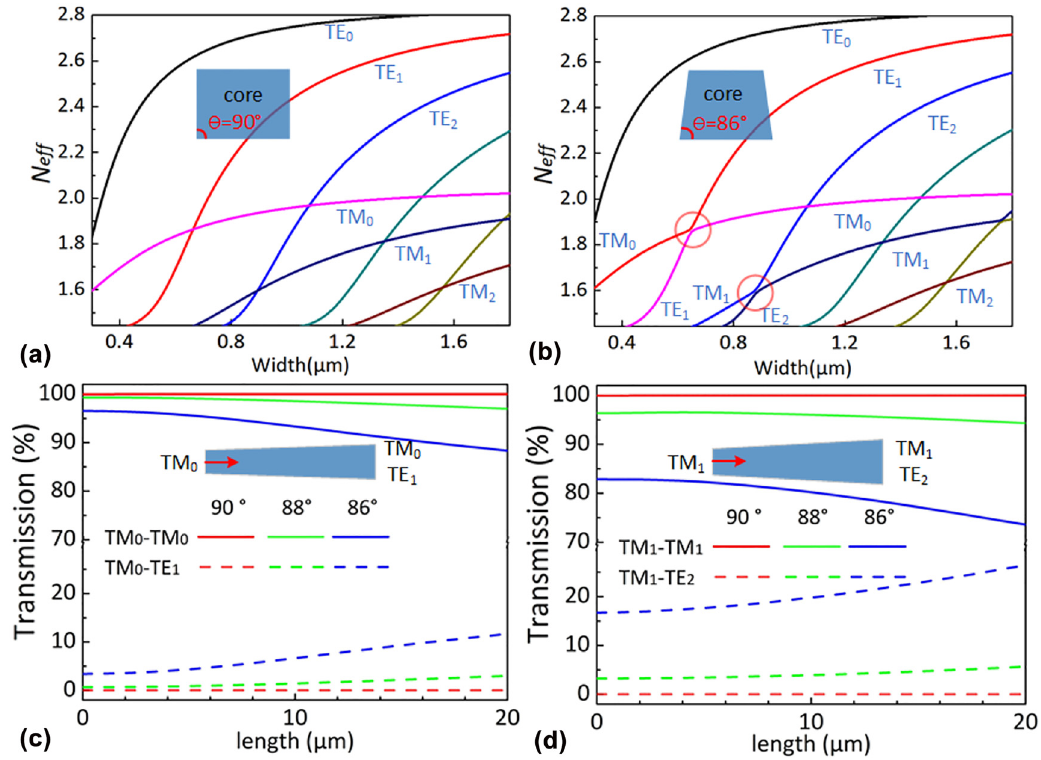
) for the silicon photonic waveguides with 90 ◦ sidewalls (a) and 86 ◦ sidewalls (b). Calculated Figure 2: Calculated mode effective index ( N eff -TM /TE in a waveguide linearly tapered from 0.6 μ m to 0.7 μ m (c) and TM efficiency of the TM 0 0 1 linearly tapered from 0.82 μ m to 0.92 μ m (d), here different lengths ( L